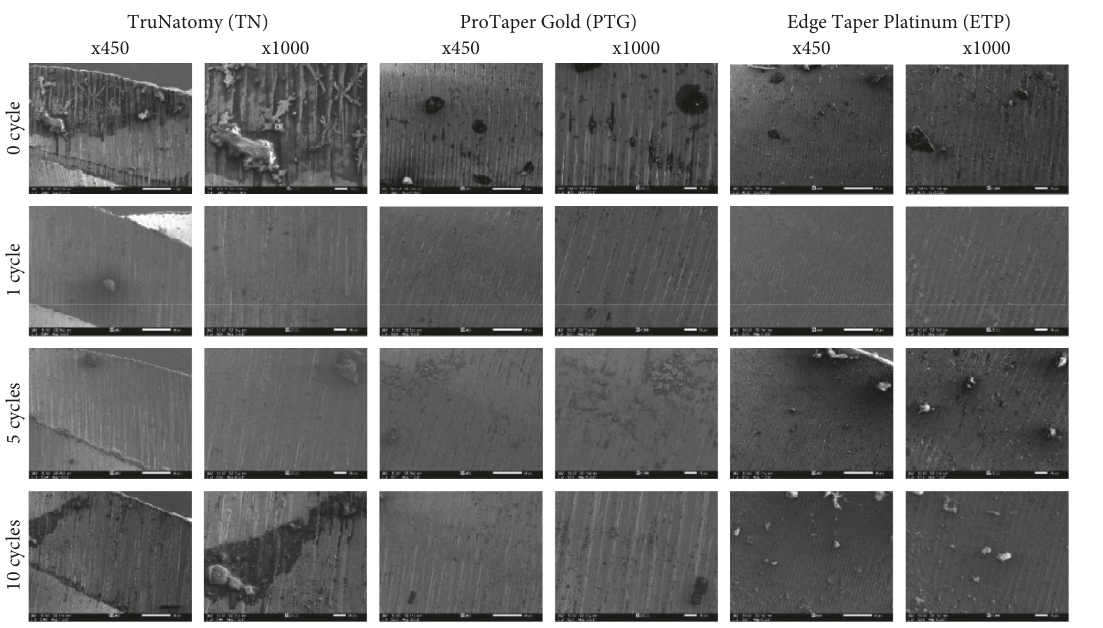
Figure 2: SEM images of TN, PTG, and ETP at magnifications of × 450 and × 1,000 for Cycles 0, 1, 5, and